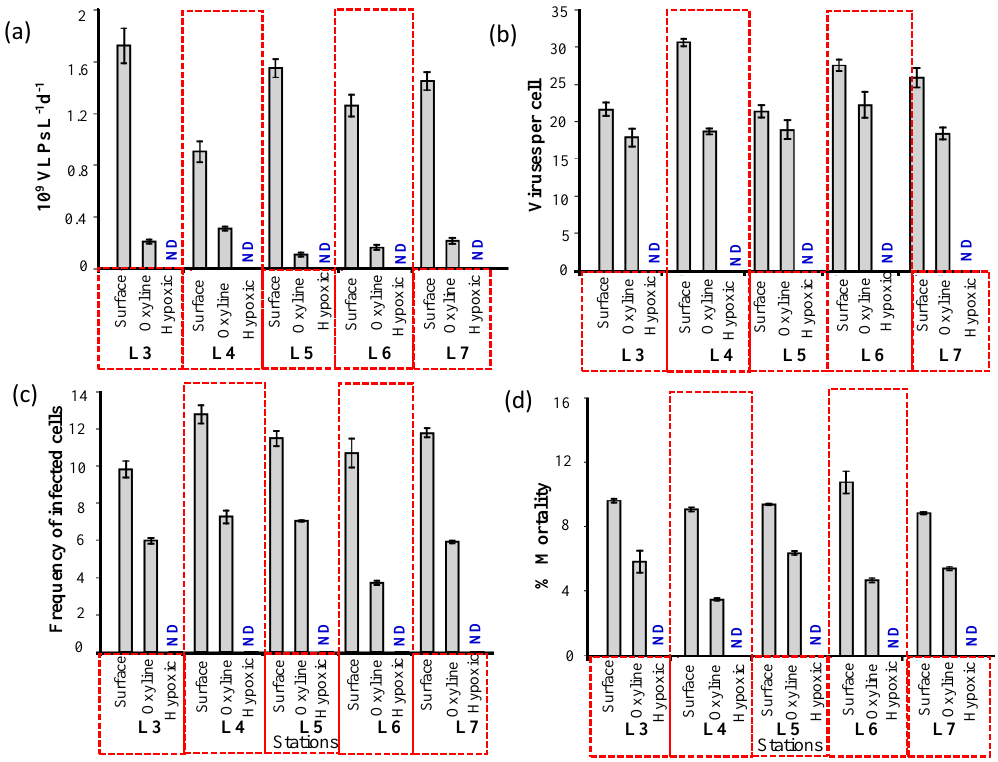
Figure 5. Represents the ( a ) Viral lytic production (10 9 VLPs L − 1 · d − 1 ) ( b ) Burst size (numbers per cell), ( c ) Frequency of infected cells (% IC), and ( d ) viral induced prokaryotic mortality (%) at various oxygen concentrations, surface, SCM, oxycline, and hypoxic layers at stations L3, L4, L5, L6, and L7. ND: Not